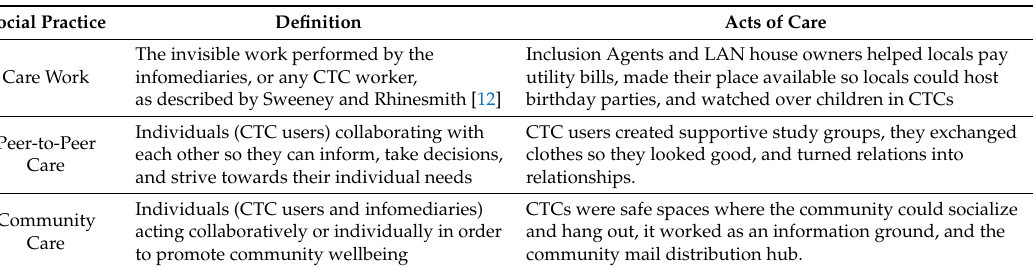
Table 1. Social practices as care in